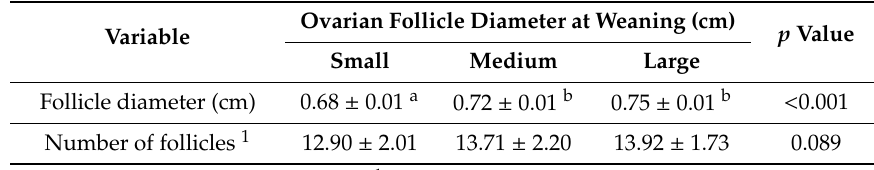
1 In each ovary.